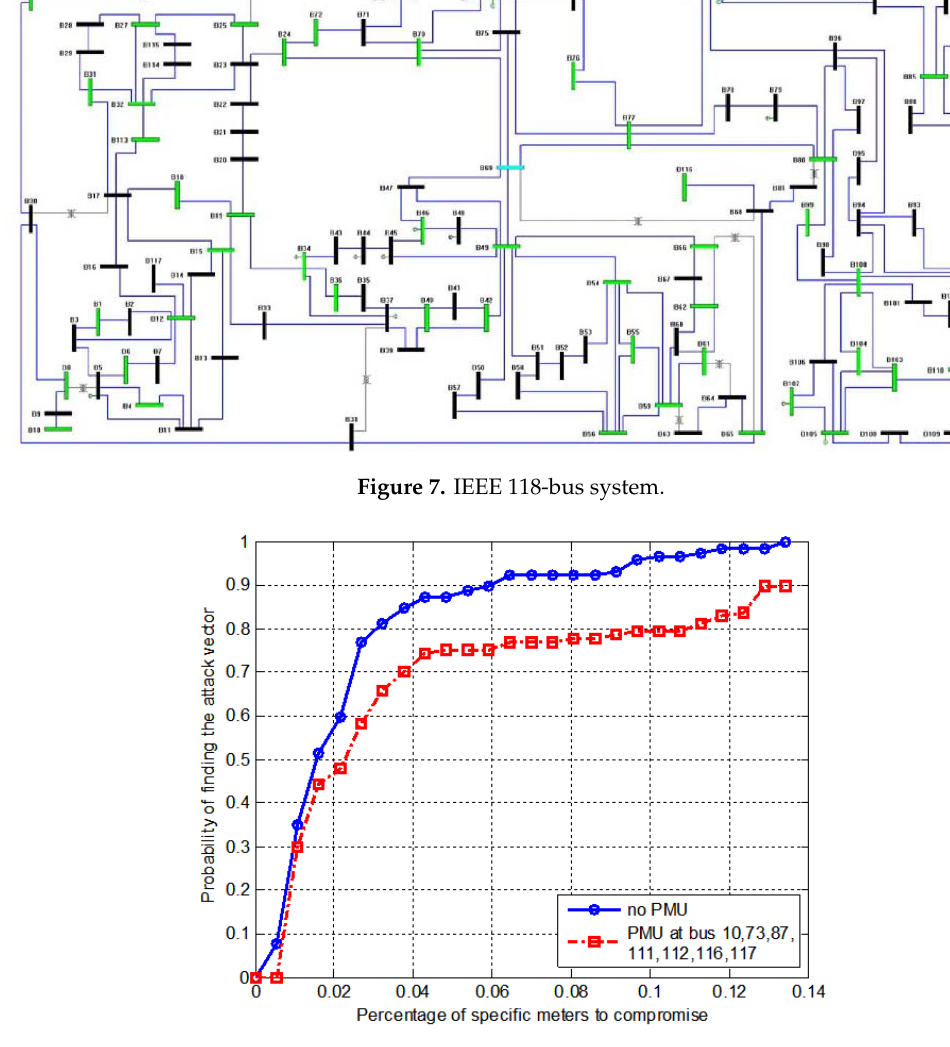
Figure 8. Probability of finding the attack vector in IEEE 118-bus system.